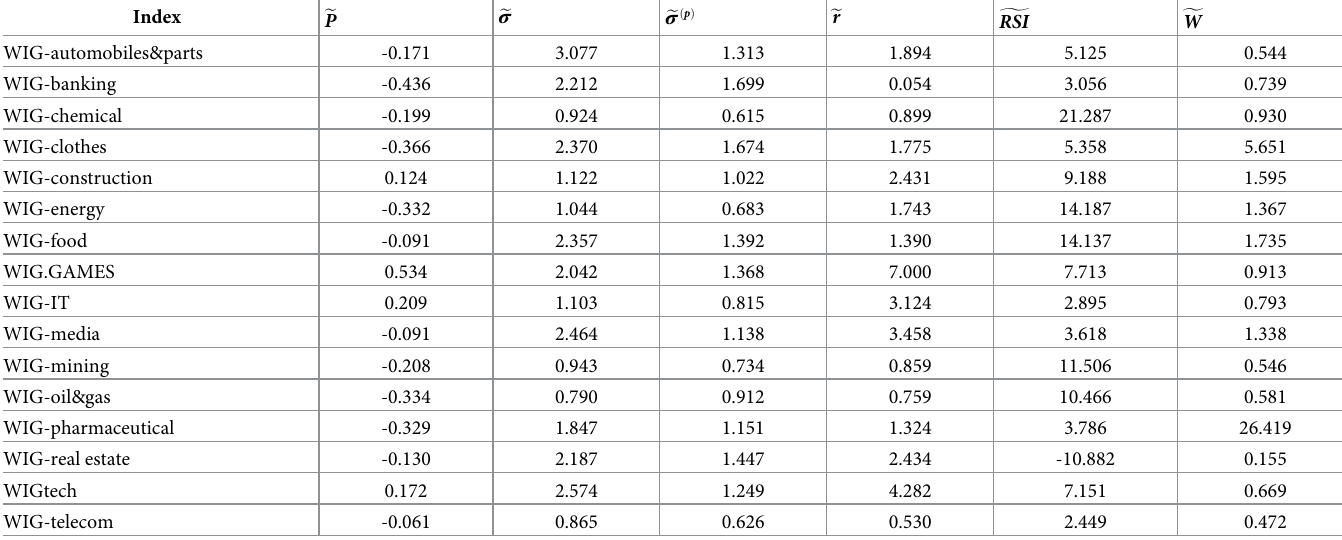
trading volume of the pharmaceutical sector (WIG-pharmaceutical), and to the lesser extent the clothing sector (WIG-clothes), for which f W is significantly higher comparing to all other sectors in all the four periods of analysis. After calculating the aforementioned six variables for all the sectors and for all the analyzed periods, we carried the clustering process on the basis of all these variables. In our study, we considered the number of clusters K = 2,3 . . . ,10 for both the K -means and Ward methods. To select the appropriate number of clusters the criterion of maximizing the silhouette coefficient was adopted. All calculations were made using own computer codes written in Python using the Scikit-learn [94] and the Yellowbrick [95] libraries. Table 5. Values of the proposed measures for evaluated